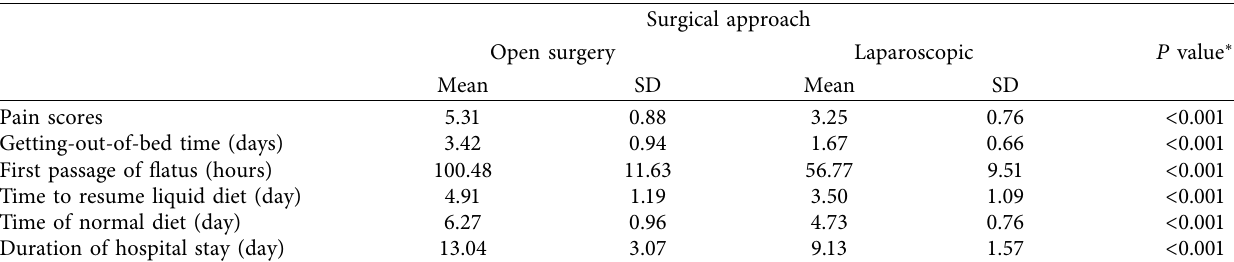
Table 3: Postoperative data according to the surgical